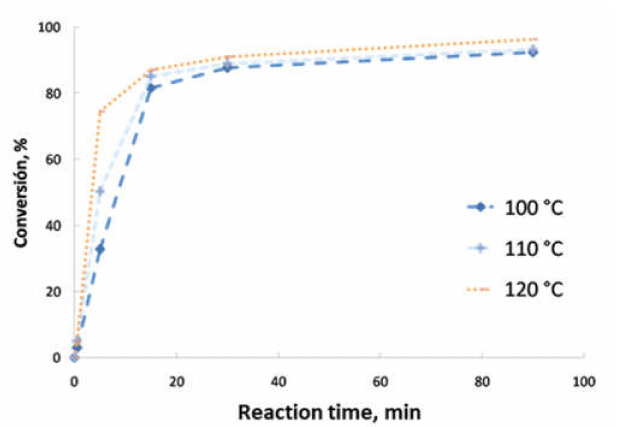
Figure 3. Effect of temperature. (FAME:alcohol ratio, 1:1; catalyst concentration, 1%; stirring rate, 500 rpm; reaction time, 90